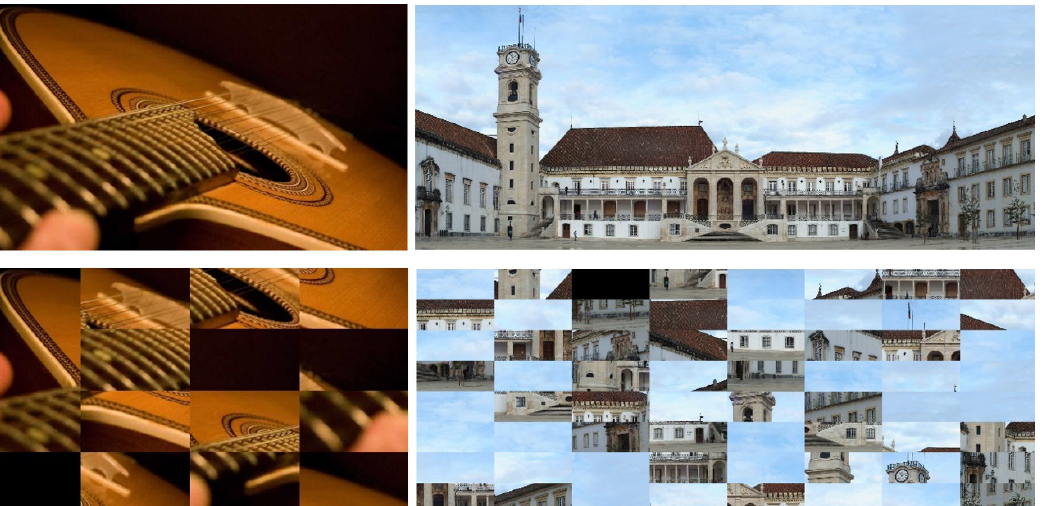
Figure 7. Sliding Block Puzzle image using 16 (left) and 64 (right) blocks (Notícias ao Minuto, n.d.; wikipedia.org, n.d.c)